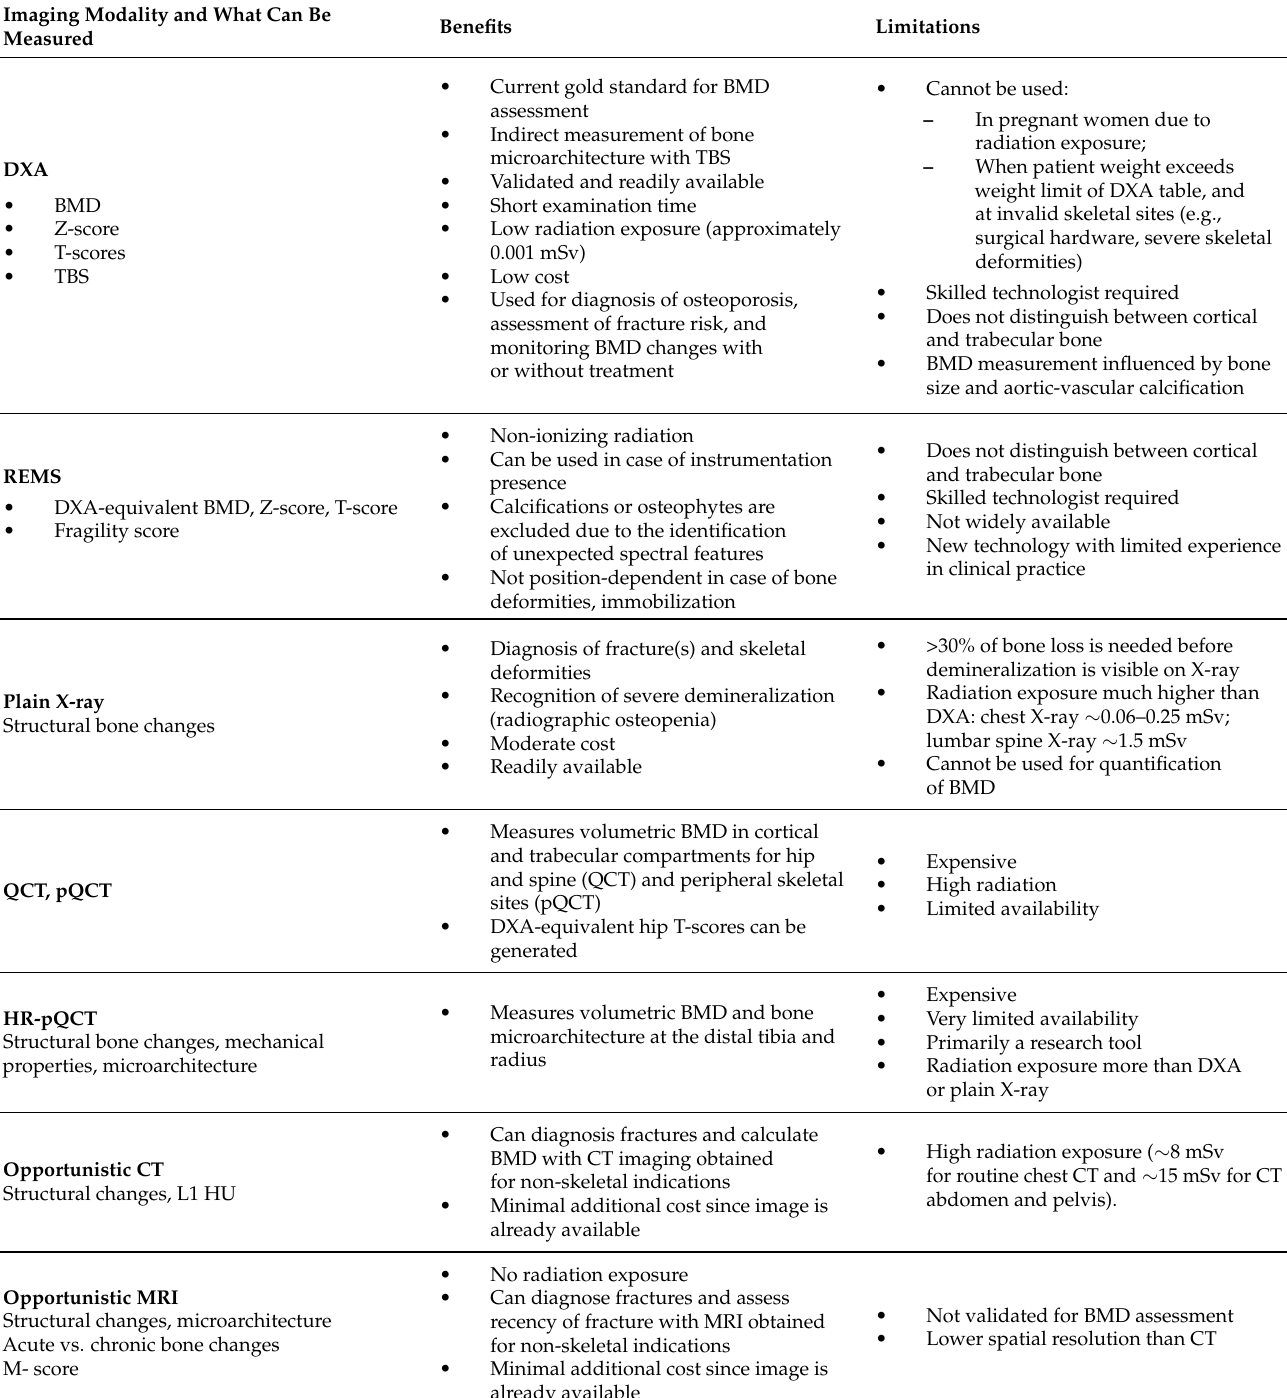
Table 3. Benefits and limitations of imaging modalities for bone health